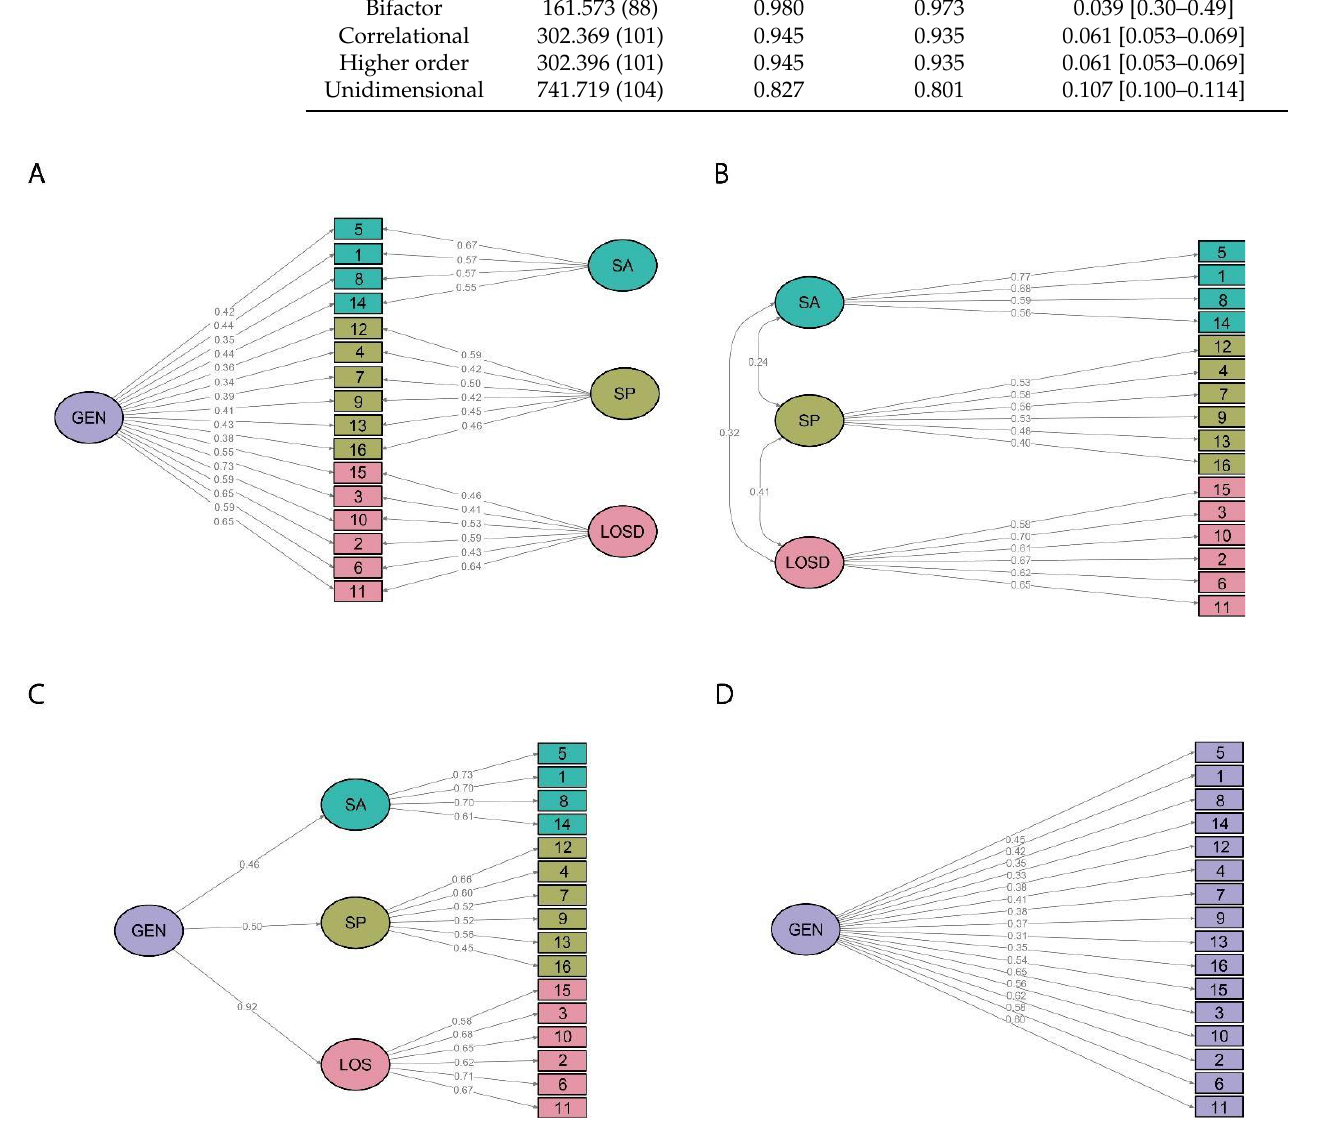
Figure 1. The Gratitude Resentment and Appreciation Test-Revised Short (GRAT-RS): factor analysis with weighted least squares means and variance adjusted (WLSMV) estimation. ( A ) bifactor model; ( B ) three-factor model; ( C ) higher-order model ( D ) unidimensional model ( n = 537). GEN: general factor; LOSD: lack of a sense of deprivation specific factor; SP: simple pleasures specific factor; SA: social appreciation specific factor. Table 2. The Gratitude Resentment and Appreciation Test-Revised Short (GRAT-RS): confirmatory factor analysis with weighted least squares means and variance adjusted (WLSMV) estimation. Fit indexes ( n = 537).